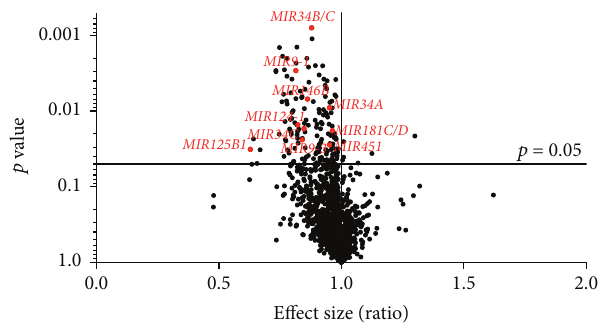
Figure 1:Volcano plot ofmethylation differences ofall theCpGsites associated with microRNA genes. In total, 161 CpG sites were found to be differentially methylated ( 𝑝 < 0.05 ) in Alzheimer’s disease (AD) group compared to controls, most of them hypermethylated; the 10 miRNA CpG sites highlighted in red map to transcripts previously reported as dysregulated in AD